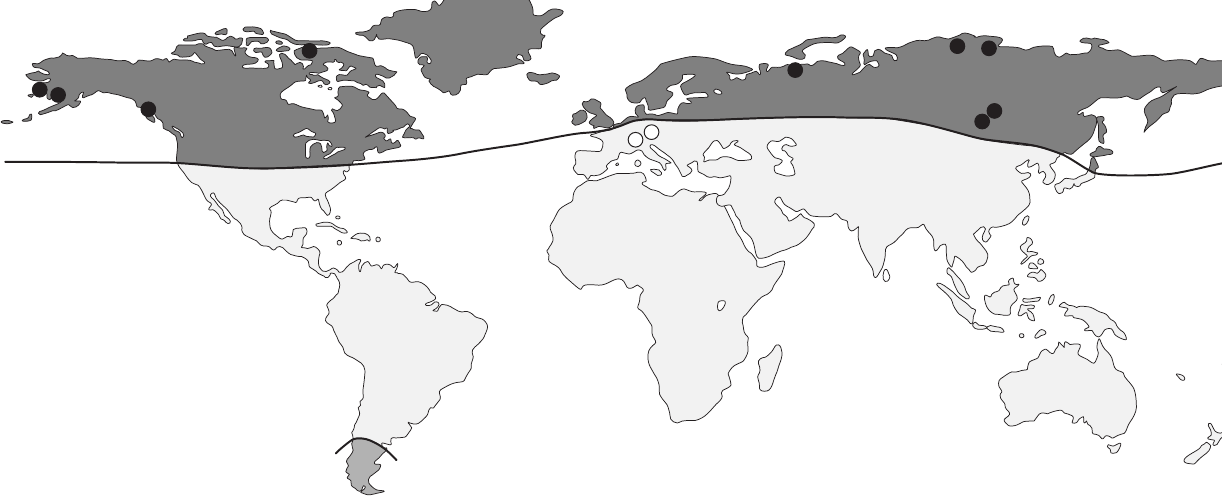
Figure 3. Geographical distribution and human cases of Diphyllobothriumdendriticum . Black dots represent autochthonous human cases; white dots represent imported human cases. Black line delimits the area of D. dendriticum distribution (grey colour).